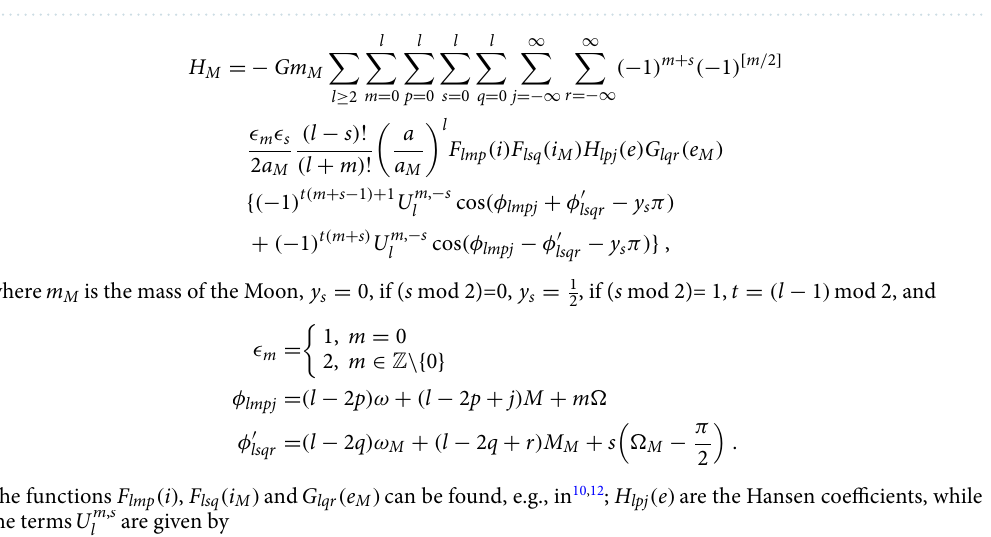
Figure 1. Comparison between the Cartesian integration of the state equations of motion (green line), Hamilton’s equations of the full Hamiltonian H (blue line), Hamilton’s equations of the doubly averaged Hamiltonian (red